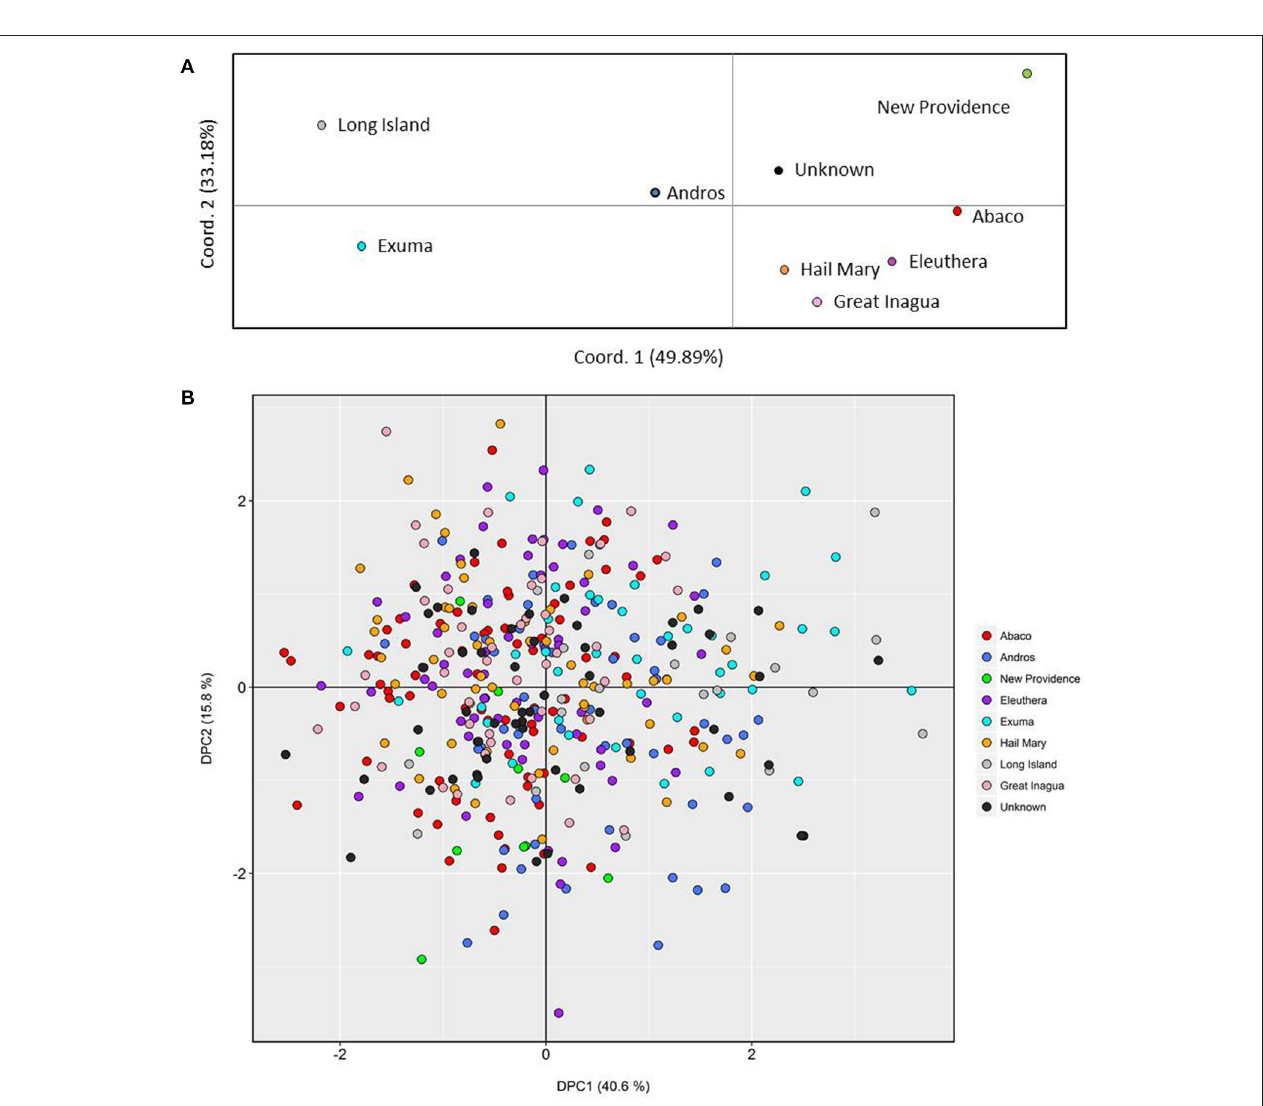
FIGURE 2 | Genetic clustering of Nassau grouper based upon 421 genotypes and inferred from (A) Principal Coordinates Analysis (PCoA) by location and (B) individual based Discriminate Analysis of Principal Components (DAPC). The per cent variation explained by each axis is presented within brackets for both the PCoA and